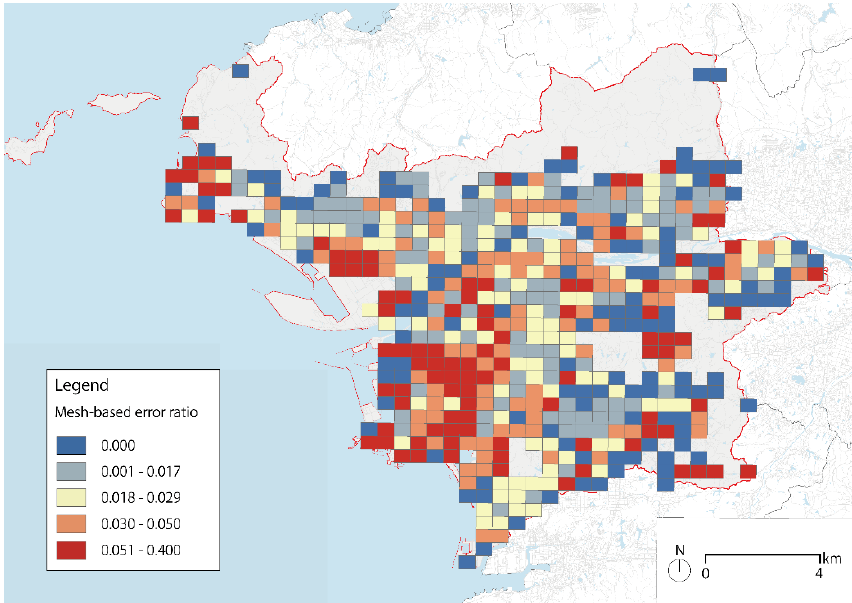
Figure 4. Geographical distribution of error ratio per 500-meter grid